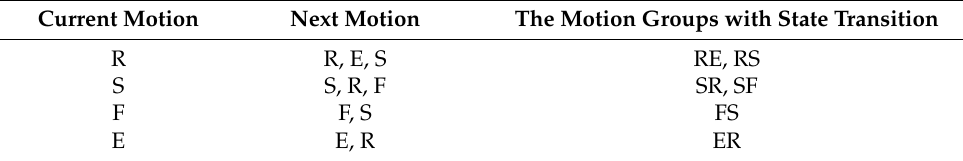
Table 1. The motion sequences of the current one and the next one.